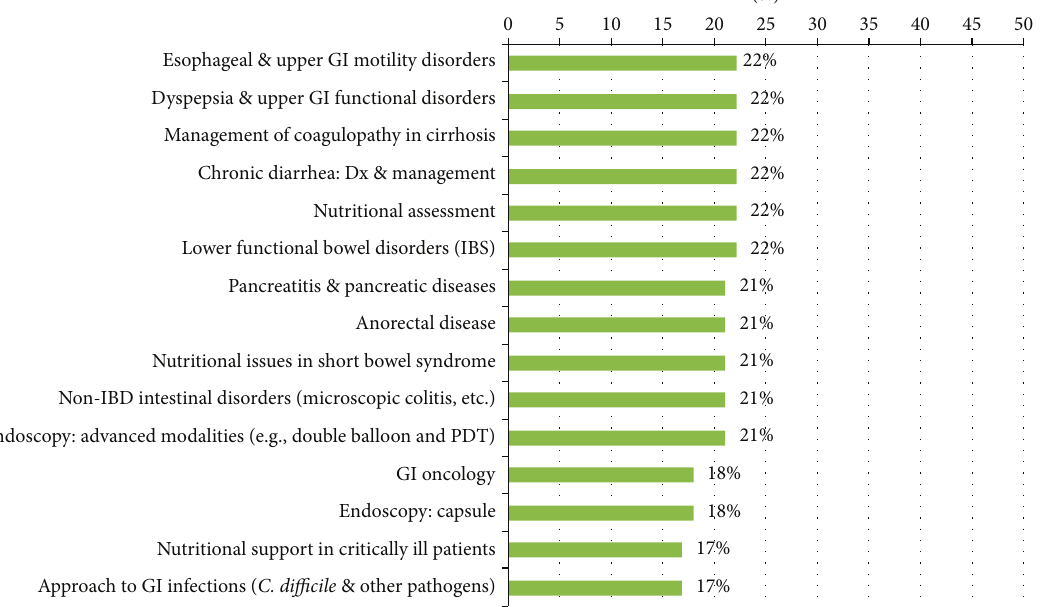
Figure 2: Educational topics in which 17–22% of respondents were “very interested.” GI: gastrointestinal; Dx: diagnosis; IBS: irritable bowel syndrome; IBD: inflammatory bowel disease; GI: gastrointestinal; C. difficile : Clostridium difficile .